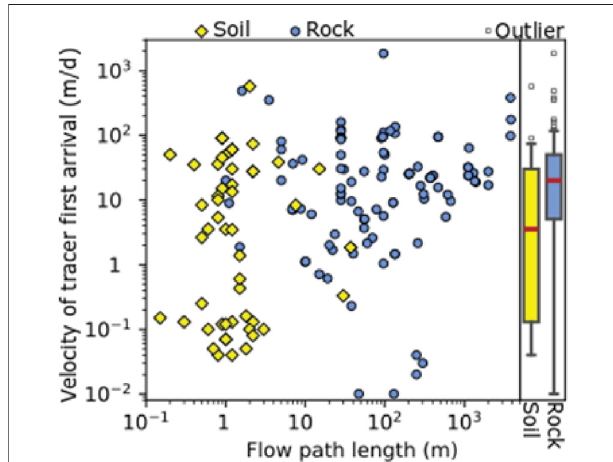
FIGURE2| Graphofvelocityoftracer fi rstarrivalindaysfordifferent fl ow path lengths in soil and rock and box and whiskers plots of velocity of tracer fi rst arrival in days in soil and rock. The bottom and top of the box are the fi rst and third quartiles, respectively. The whiskers extend 1.5 times the interquartile range beyond the fi rst and third quartiles. The term “ outliers ” denotes points that extend beyond the whiskers, without implying any insigni fi cance. Median velocity of tracer fi rst arrival (red line in the box plots) was 3.5 m/d in soil and 20 m/d in rock. Data were harvested from the peer- reviewed literature listed in Supplementary Table S1